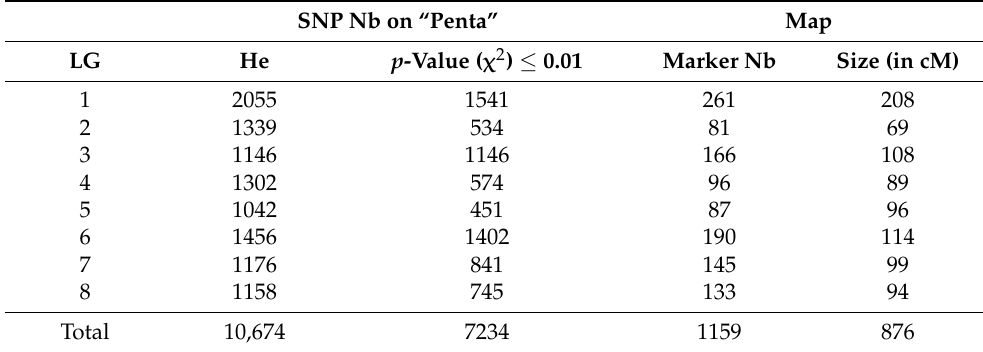
Table 4. Efficient markers to create genetic map for a F2 biparental population. (LG: Linkage group, He = Heterozygote, Nb =